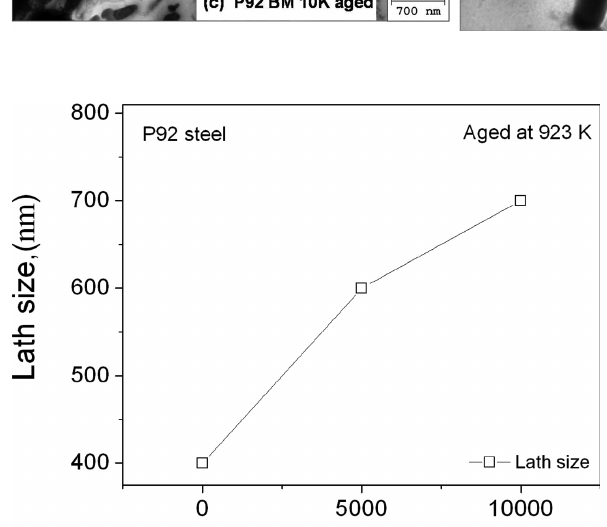
Figure 2: TEM micrographs of P92 steel in the (a) normalized and tempered, and thermal-aged condi- tion at 923 K for (b) 5000 h and ((c) and (d)) 10,000 h.